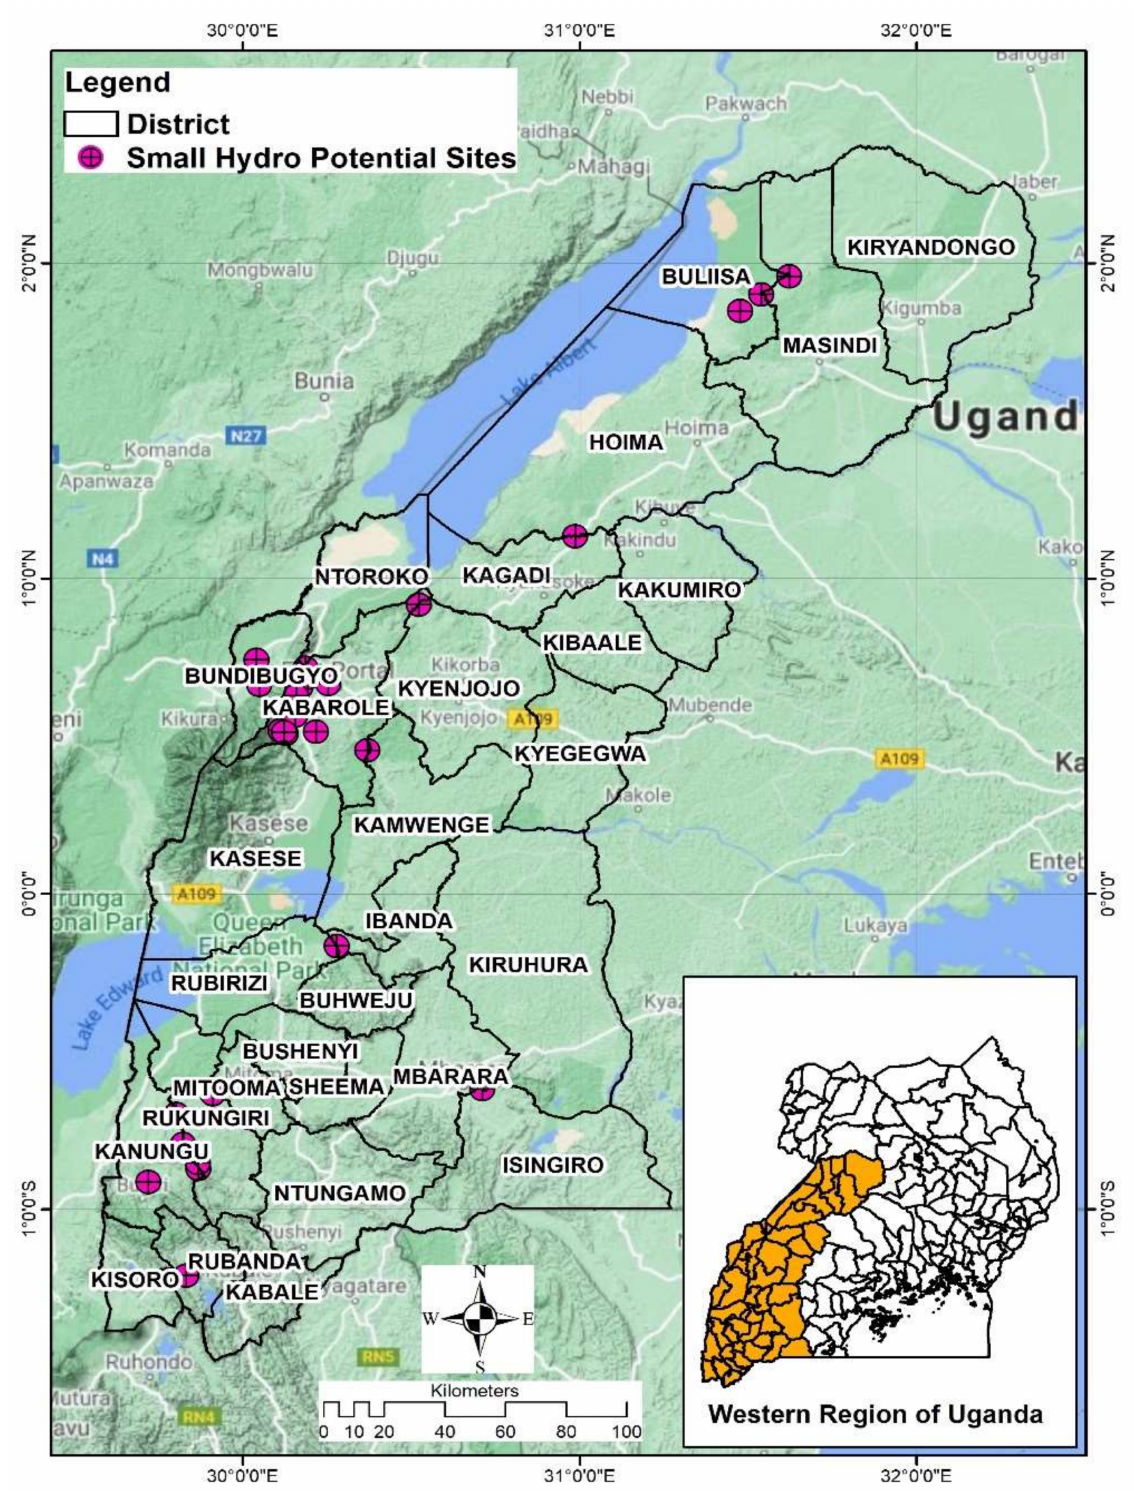
Figure 12. Map showing small hydro potential sites in the study